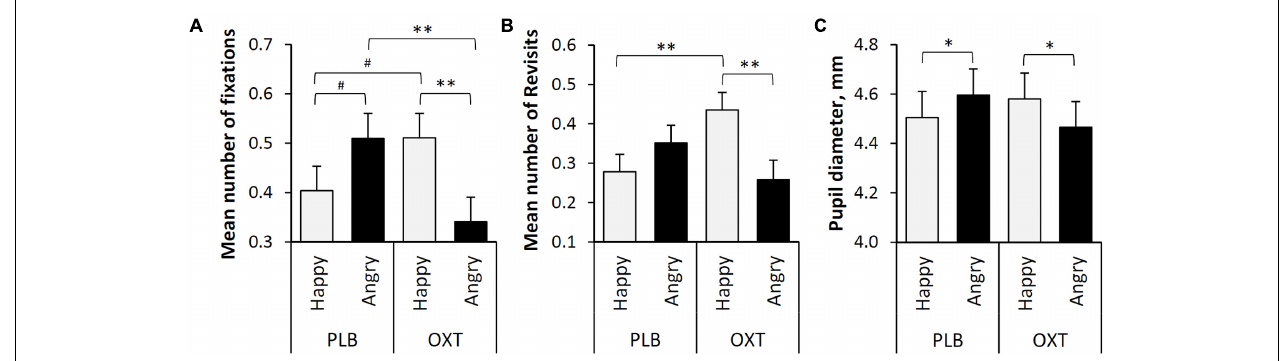
FIGURE 2 | (A) The mean number of fixations targeted to the eye regions of happy and angry faces (Lg10 transformed values). (B) The mean number of revisits targeted to the eye regions of happy and angry faces (Lg10 transformed values). (C) The mean pupil diameter (mm) during the presentation of two facial expressions (Happy and Angry) and two treatments (PLB and OXT). Error bars represent SE . Asterisks indicate significant differences ( ∗∗ p < 0.01, ∗ p < 0.05) and a statistical trend ( # p <